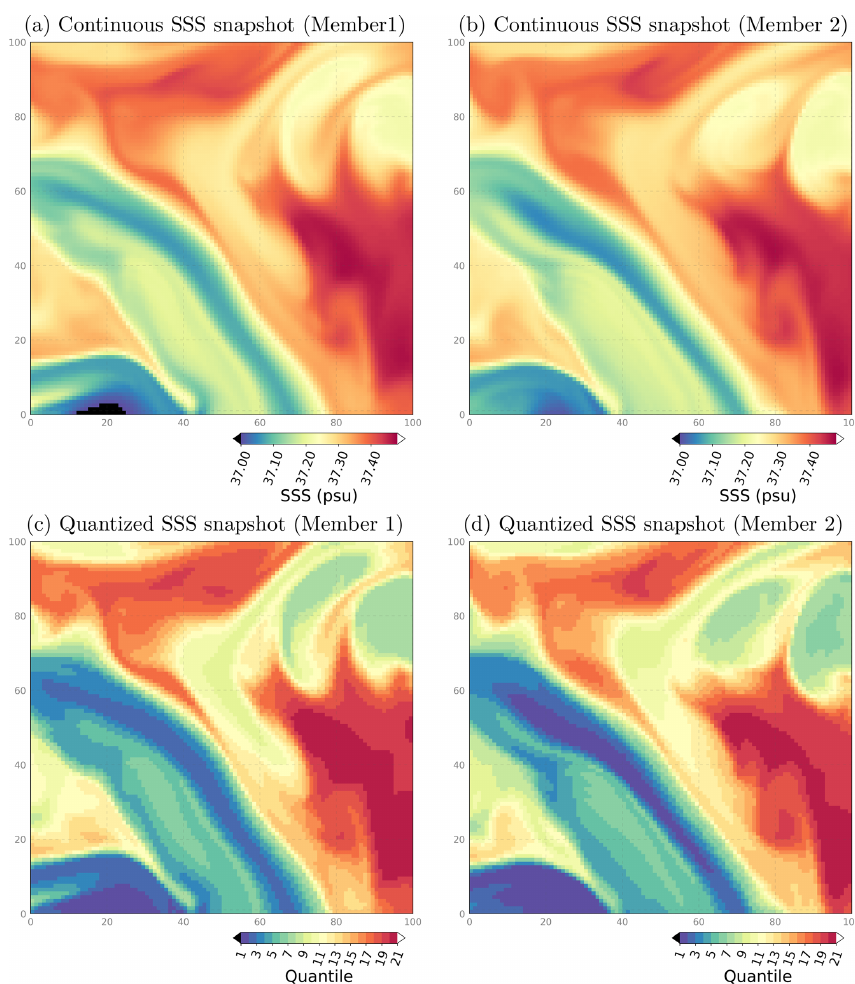
Figure 12. Surface sea salinity (SSS) hourly snapshots from two example members of experiment ENS-CI after 15d, focusing on a 100 × 100 subregion southeast of the Balearic Islands: box (c) in Fig. 1. The original continuous fields are shown in the top row (a, b) and their quantized version (c, d) in the bottom